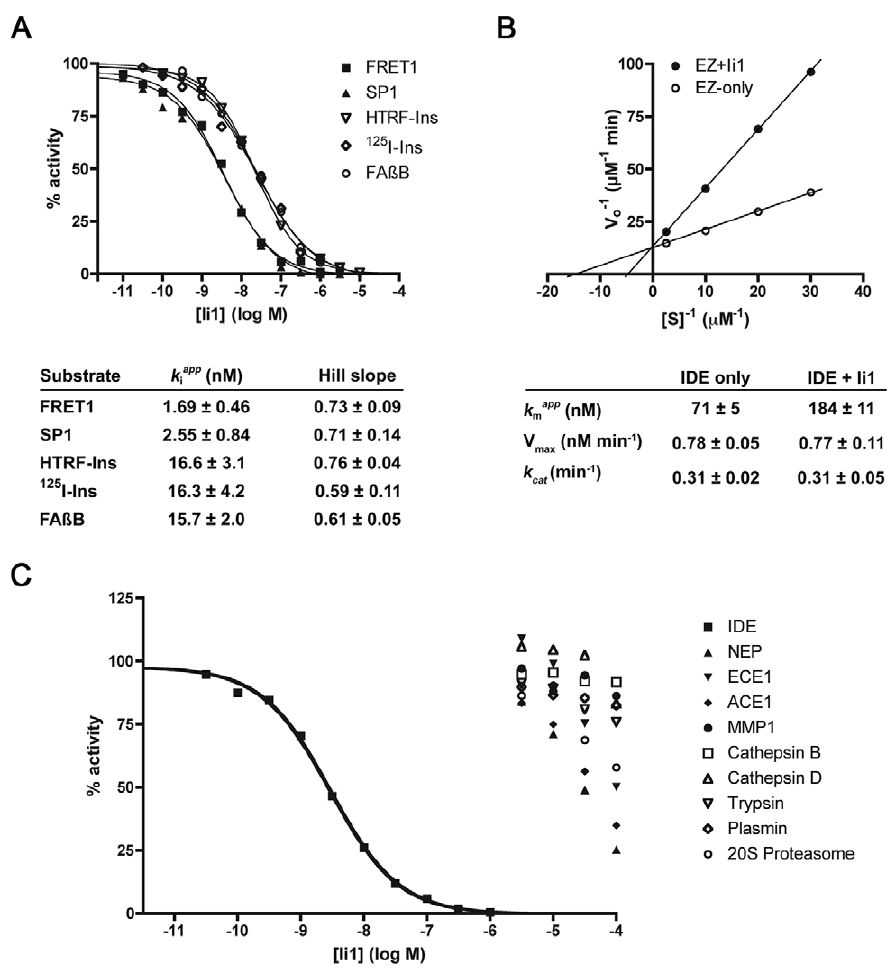
Figure 3. Invitro enzymatic analysis of IDE inhibition by Ii1. A , Representative dose-response curves for a variety of IDE substrates and K i values and Hill slopes computed from 4 to 6 replications per substrate. Note that [S]/ K M was kept constant for dose-response studies, permitting visual comparison of relative K i values. B , Lineweaver-Burk plot of IDE-mediated insulin degradation in the absence or presence of Ii1 (30 nM) and kinetic parameters calculated from 4 independent experiments. These data were obtained using recombinant human insulin and 125 I-insulin at a fixed ratio (1000:1), as described [48]. Note that the mode of inhibition is purely competitive, and was also observed using A b (Fig. S3). C , Dose-response curves showing the selectivity of Ii1 for IDE as compared to several other zinc-metalloproteases—neprilysin (NEP), endothelin-converting enzyme-1 (ECE1), angiotensin-converting enzyme-1 (ACE1) and matrix-metalloprotease-1 (MMP1)—and representative members of other protease classes, including cysteine (cathepsin B), aspartate (cathepsin D), serine (trypsin and plasmin) and threonine (20S proteasome). Data are mean of 2 to 3 experiments per condition.